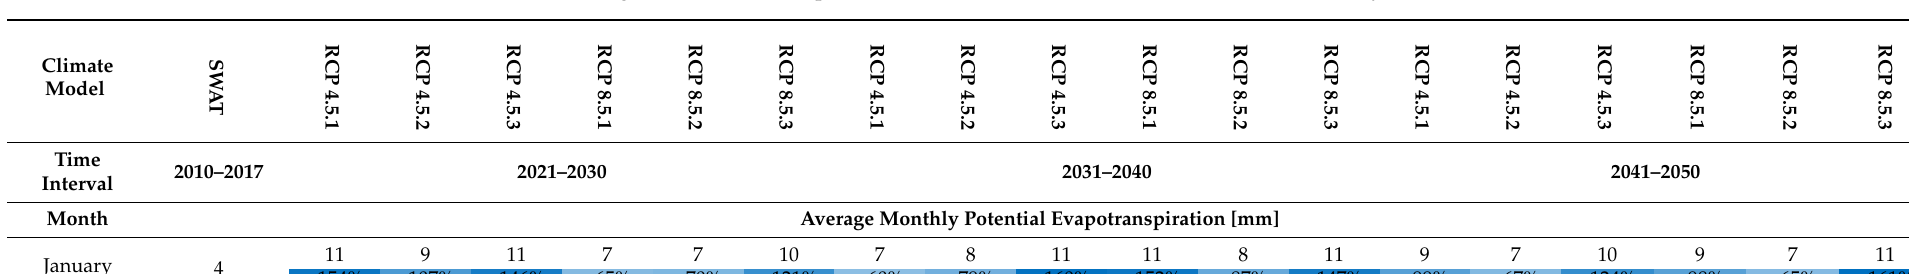
Table 9. Comparison of the average monthly sum of potential evapotranspiration for the SWAT simulation period 2010–2017 with individual projections for the